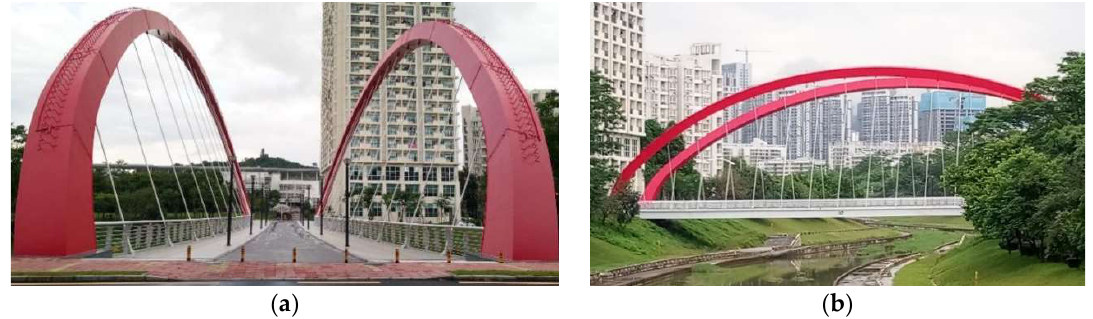
Figure 6. Front view and lateral view of the Rainbow Bridge: ( a ) front view; ( b ) lateral view.